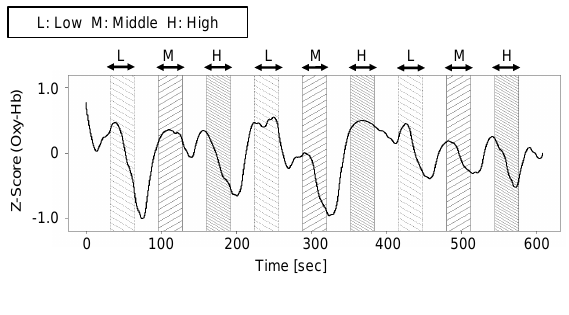
Fig. 9. Brain activity in Arithmetic